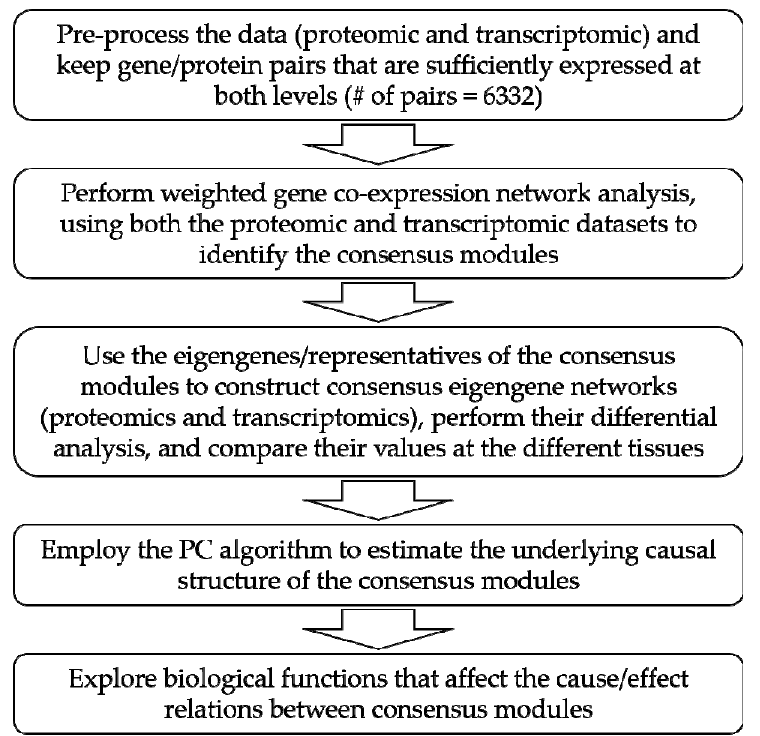
Figure 1. Flowchart of the analysis.